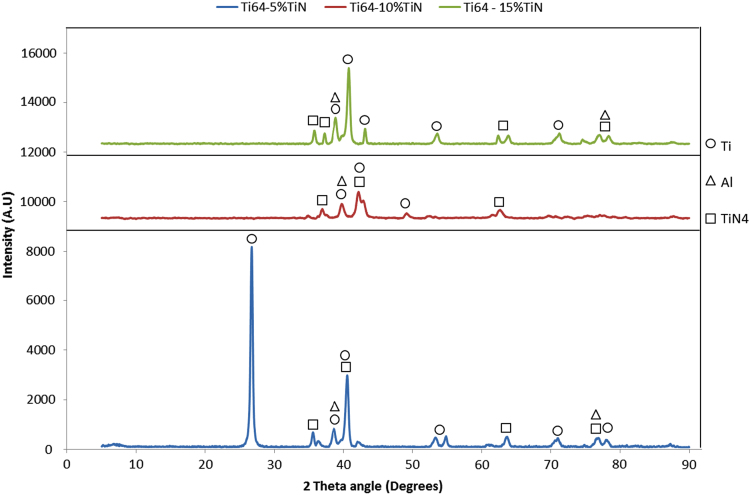
XRD diffractogram of Ti–6Al–4V–xTiN.